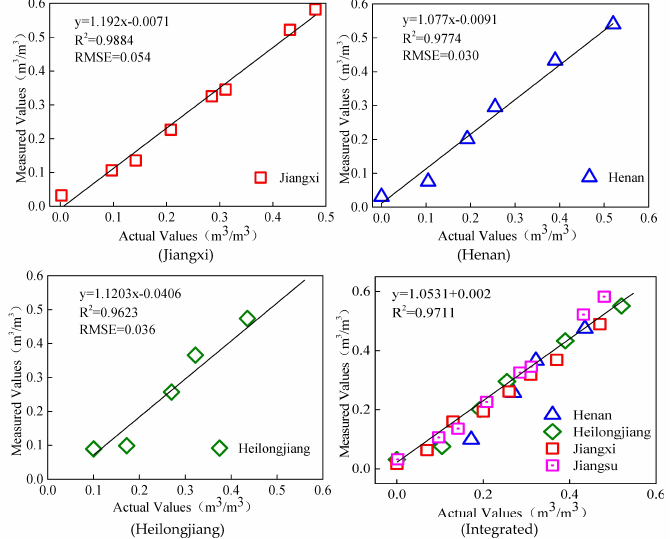
Fig. 4 Schematic diagrams of the relationship between the number of college sports performance levels and the goodness of fit